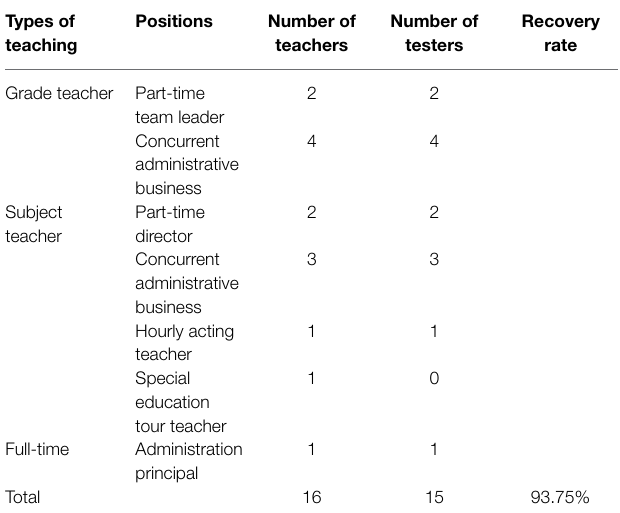
TABLE 2 | Respondents and number of